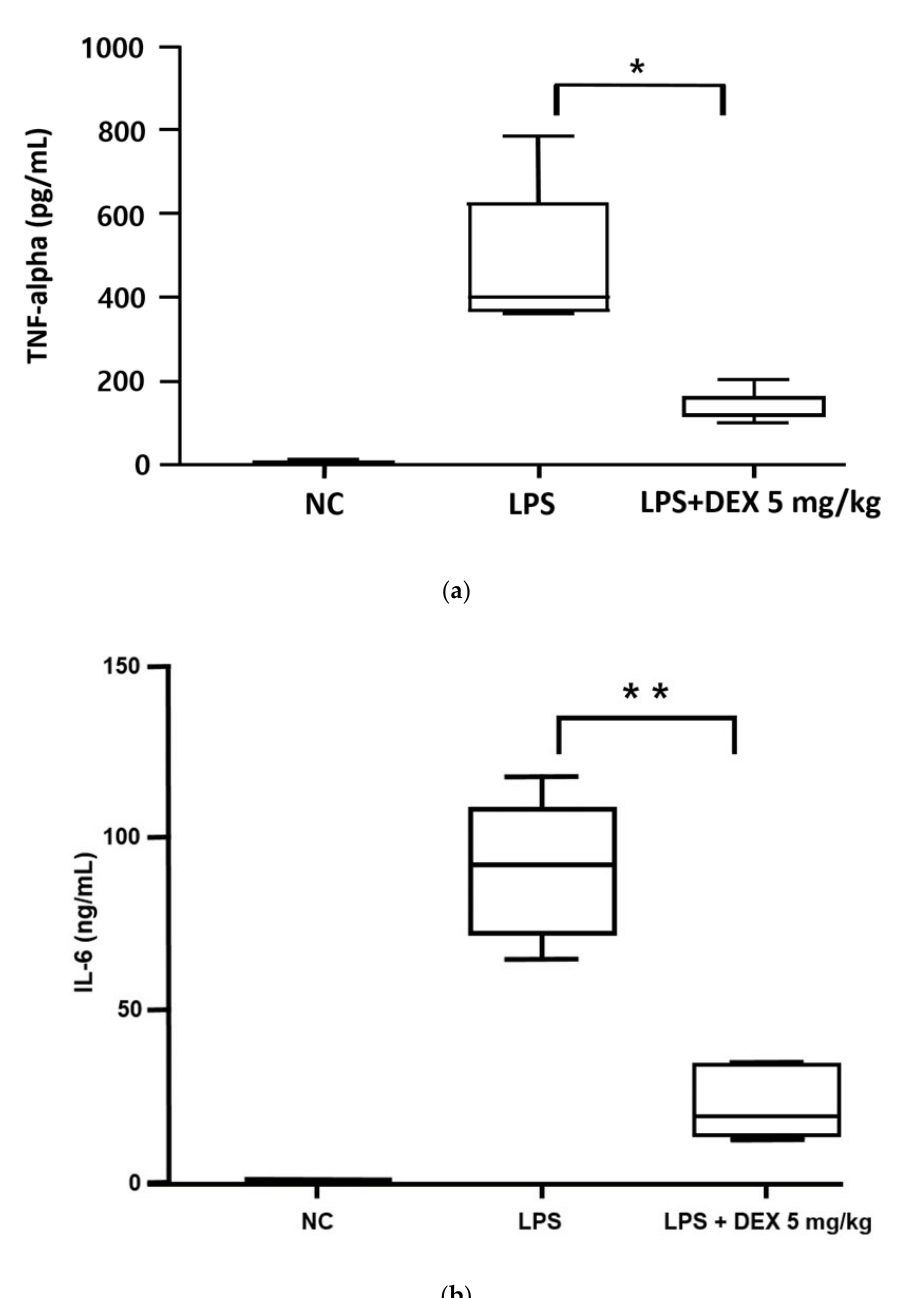
Figure 3. Serum cytokine concentrations 4 h after LPS administration: ( a ) TNF- α and ( b ) IL-6. The data are expressed as mean ± standard error (* p < 0.05, ** p < 0.01, adjusted p -value by Bonferroni- Holm method). NC—normal control.